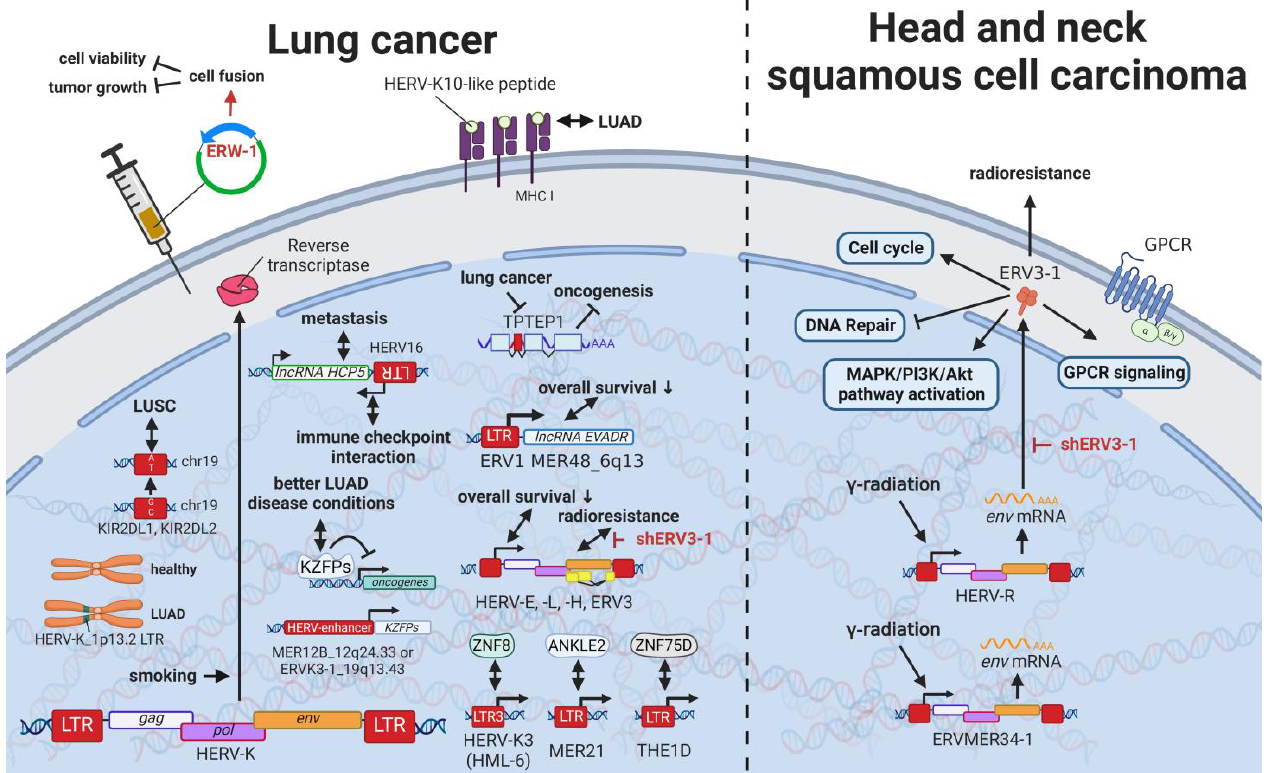
Figure 10. The role of HERVs in lung, head, and neck cancer. Evaluated treatments are marked in red. Abbreviations: LUAD = lung adenocarcinoma, LUSC = lung squamous cell carcinoma, GPCR = G- protein-coupled receptor, LTR = long terminal repeat, gag = group antigen (capsid), pol = polymerase, env = envelope. If not otherwise stated HERV-K =